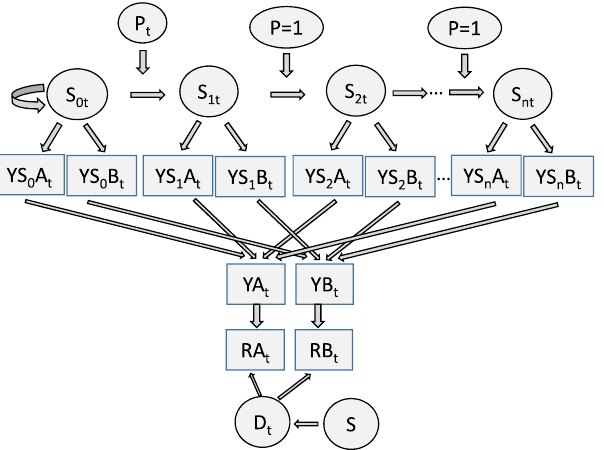
Figure 2. Representation of the system as an n + 1 state Hidden Markov Model. P t is the probability of transition from state S 0 to S 1 at time t. S it is the probability of the model being in state i at time t. YS i A t /B t is the number of observed cases of syndrome A and B emitted by state i at time t. D t is the probability that a syndrome observed at time t was reported at the time of observation (s). Finally, RA t /B t is the number of observed syndromes that was reported from time t as seen on day